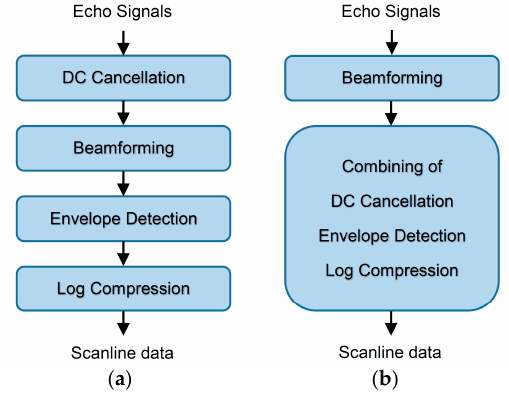
Figure 2. Block diagrams of the processes used for the ultrasound image reconstruction in the conventional ( a ) and the proposed ( b )